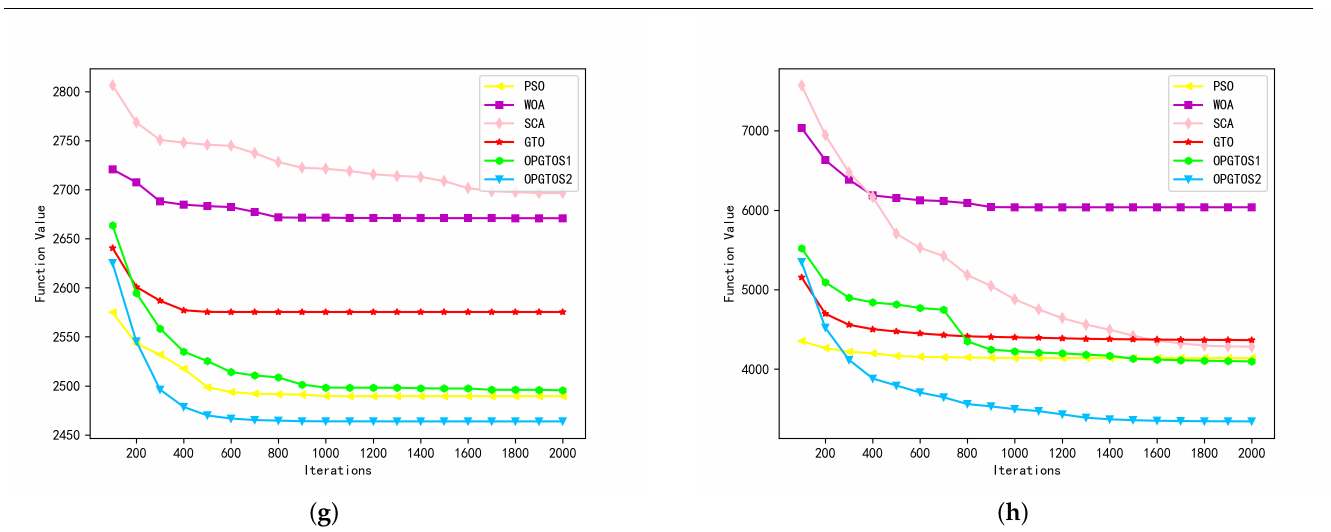
Figure 8. Simulation results of composition functions in 30 dimensions. ( a ) F21. ( b ) F22. ( c ) F23.